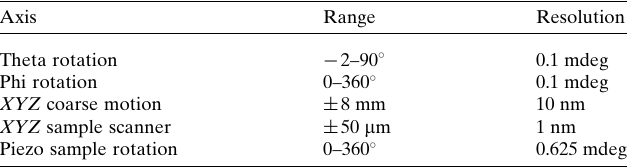
Table 1 A summary of the range of rotations and translations available for the sample, and respective resolution.